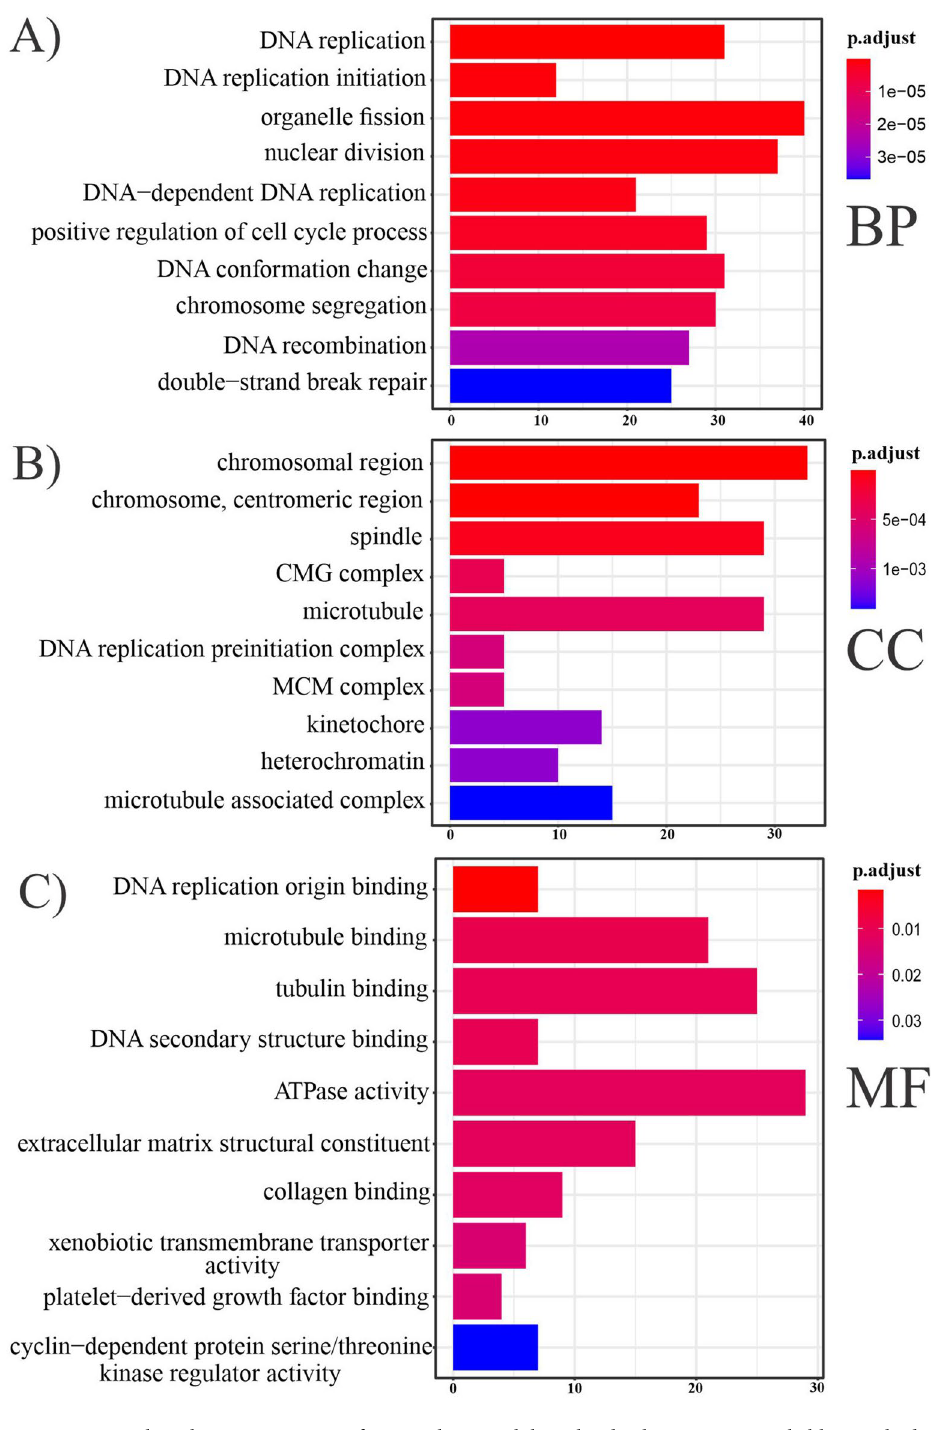
Figure 6. Bar plots show an overview of GO analysis, each bar plot displaying ten remarkably enriched terms in three categories ( A) biological process, ( B) cellular component, ( C) molecular function. The terms at the top of the barplot are more significant than the other